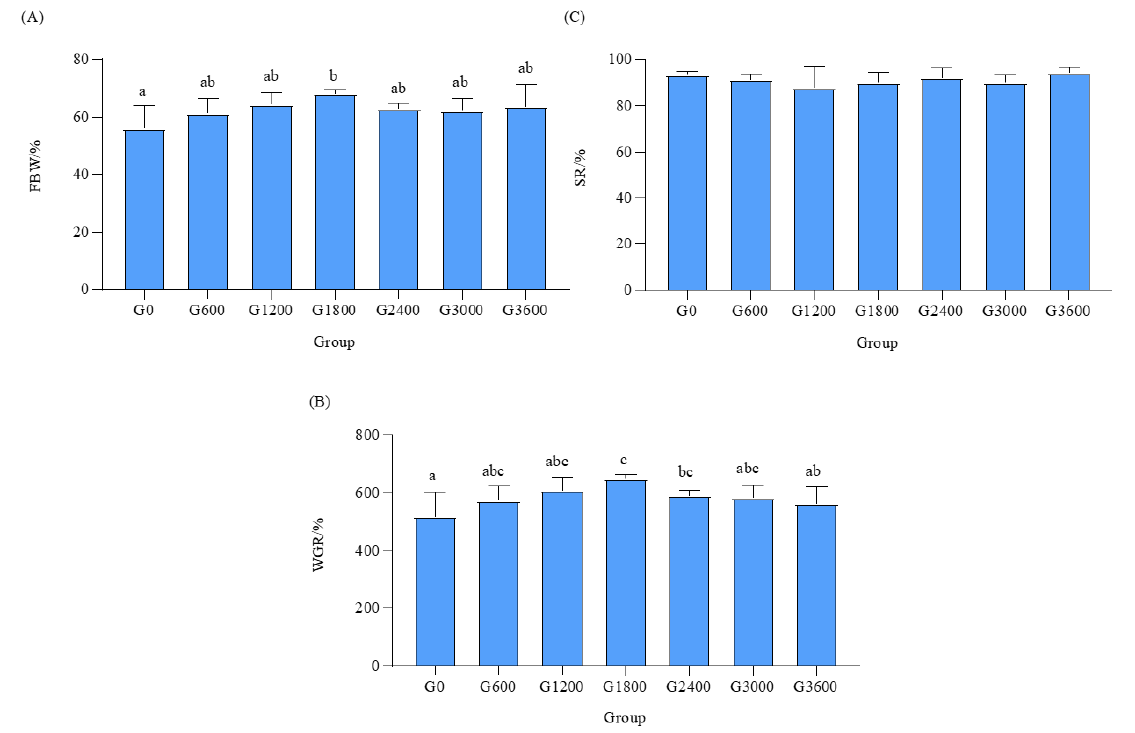
Figure 1. Effects of dietary GML levels on growth performance for juvenile grouper. Data repre- sent means of three tanks in each group; error bar indicates S.D. Values with different letters are significantly different ( p < 0.05). ( A ) FBW: weight body weight. ( B ) WGR: weight gain rate. ( C ) SR: survival rate. Table 3. Effects of dietary GML levels on antioxidant index of juvenile grouper.